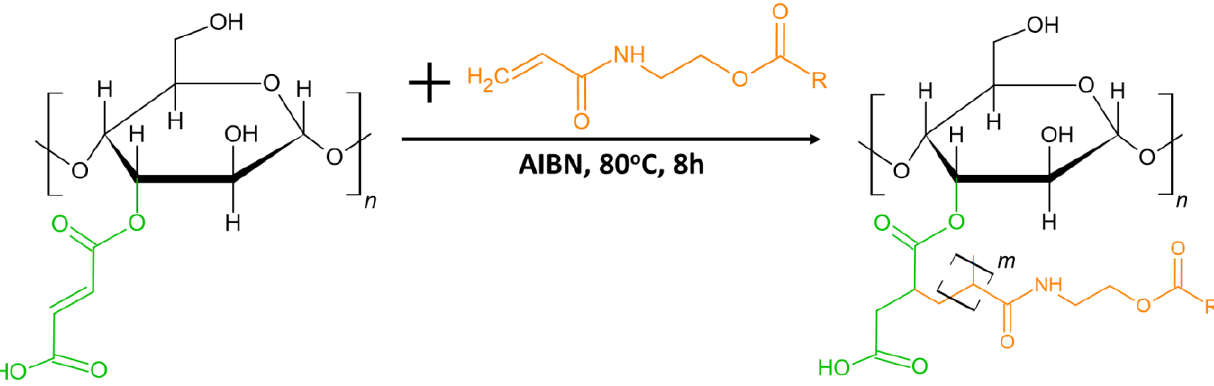
Figure 3. Synthetic scheme of BBM-Xylan grafted copolymerization.